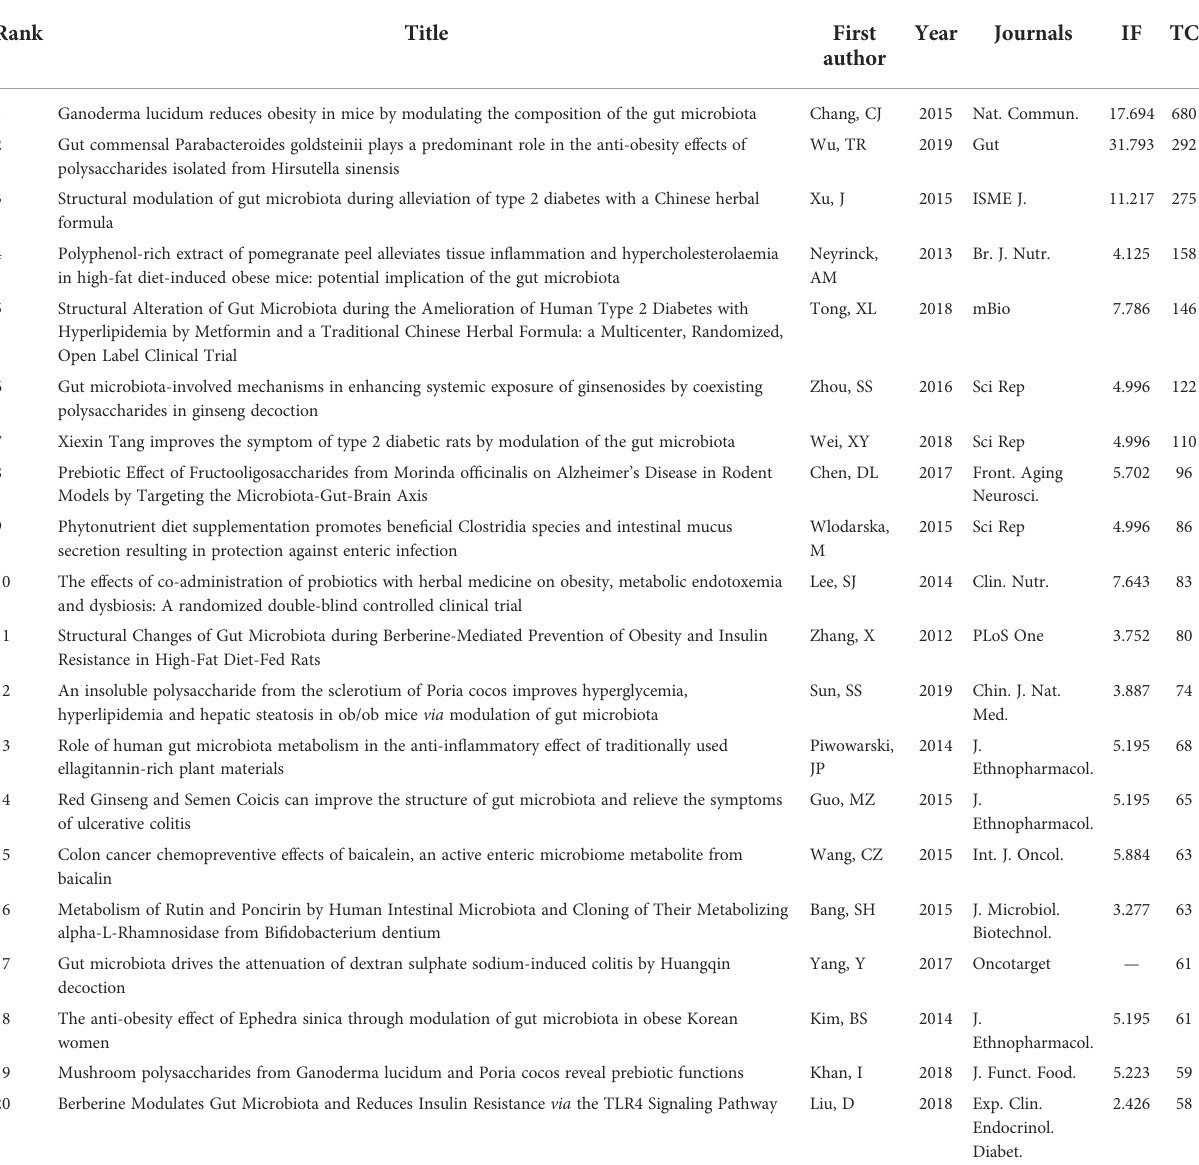
TABLE 6 The top 20 cited original research articles related to the